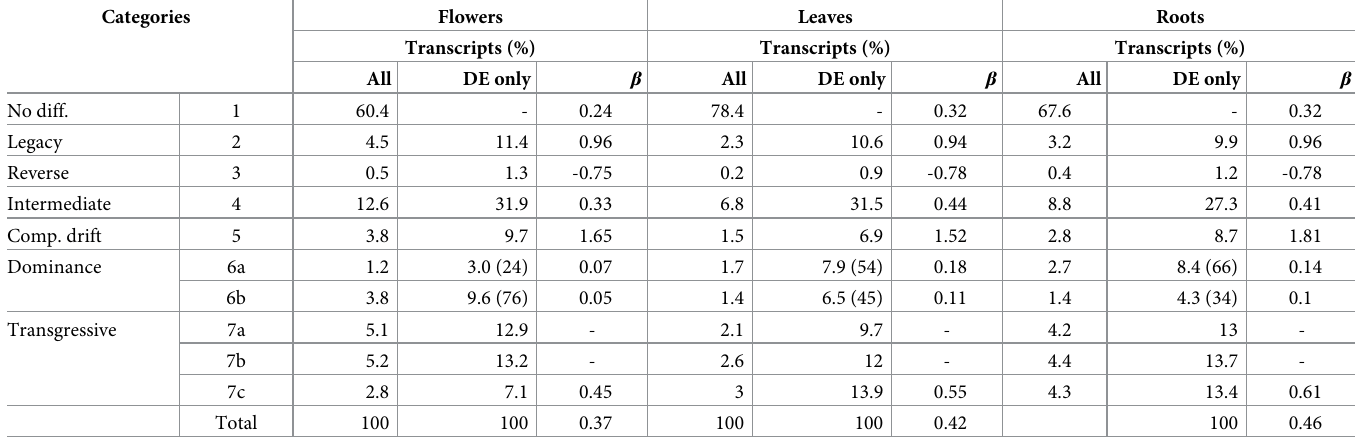
Table 1. Expression variation of C. bursa-pastoris subgenomes relative to expression in parental species across different tissues. The percentage of transcripts within each category is given for all genes or only differentially expressed genes ( i.e , without No difference category). The slope of the regression of relative expression between sub- genomes and relative expression between parental species for all genes per category is also provided ( β , see Fig 5). The percentages of transcripts showing a dominance of either Cbp Cg or Cbp Co are given in